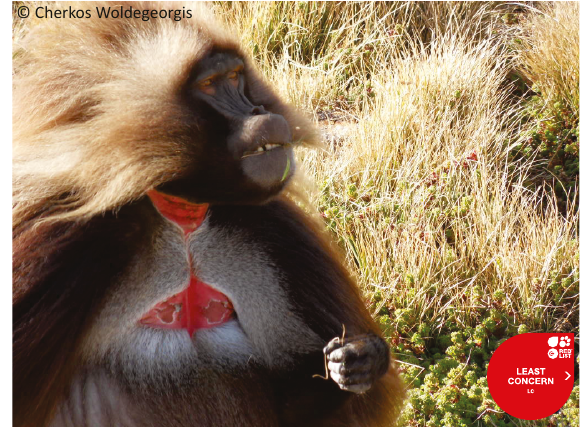
focal animal was chosen from individuals furthest away from the previous focal individual. Each focal